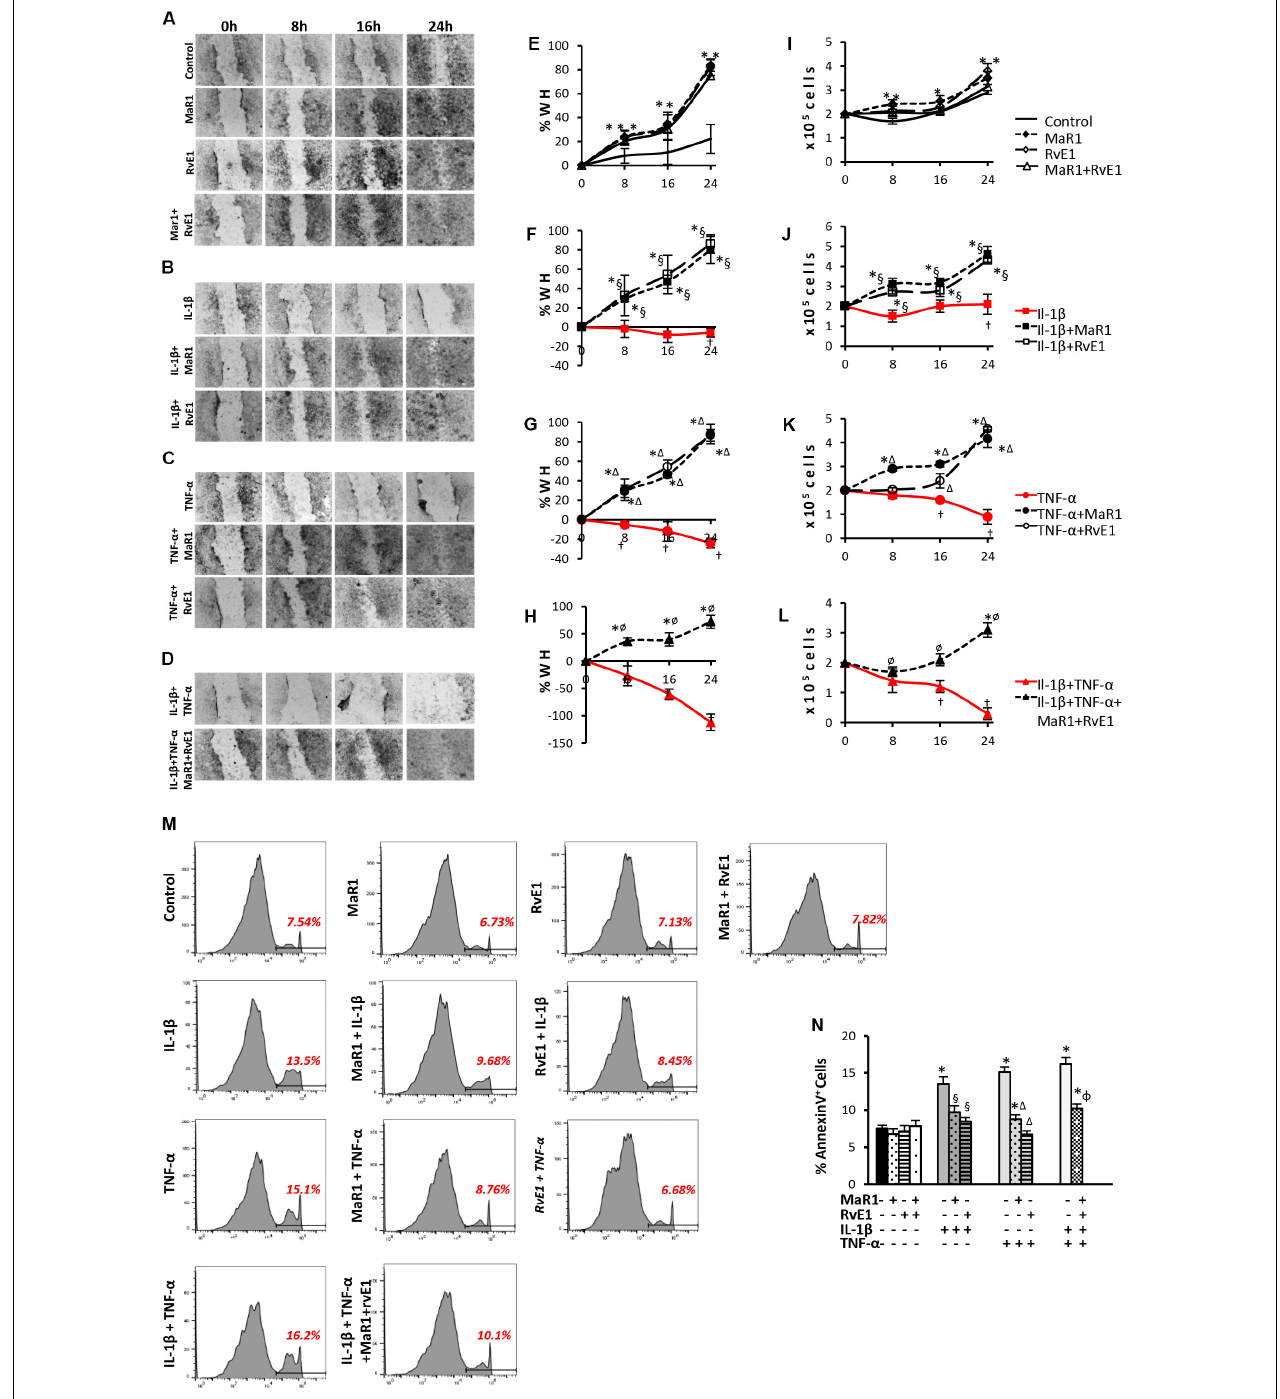
FIGURE 2 | Analysis of hPDLSCs migration, viability, and apoptosis in wound closure assay using scratches in monolayers with ∼ 2 × 10 5 cells unstimulated (control) or stimulated under different experimental conditions. (A–D) representative images in 10X magnification at each time-point (Baseline/0, 8, 16, and 24 h). (E–H) percentage of wound healing at each time-point. Positive values correspond to the reduction of the wound area, and negative values correspond to an increase in this area. (I–L) values relative to the total number of viable cells using MTT assay at each time-point. (M) representative histograms of flow cytometry analysis using AnnexinV set in unstained cells to analyze positive populations. (N) Percentage of AnnexinV + hPDLSCs (early apoptotic cells) after 24 h treatment under different conditions. (*) p < 0.05 vs control (non-stimulated); (§) p < 0.05 vs IL-1 β treated group; ( (cid:49) ) p < 0.05 vs TNF- α treated group; and ( ø ) p < 0.05 vs IL-1 β +TNF- α treated group. ANOVA with post-hoc test Tukey was used to determine statistical differences between experimental groups at the 0.05 level. Results are given as mean ± SEM of three independent experiments.